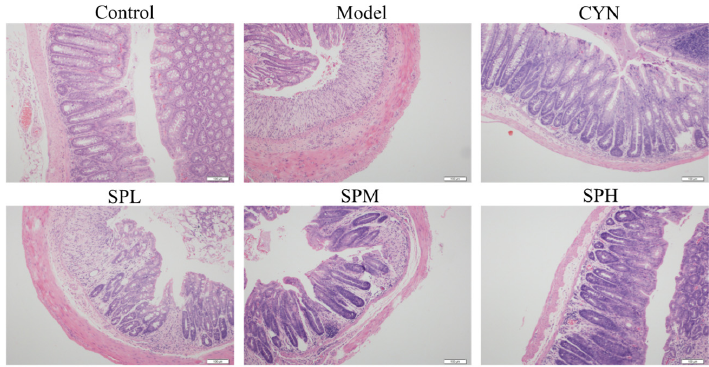
Figure 6. The typical H&E staining photos of the colon section.